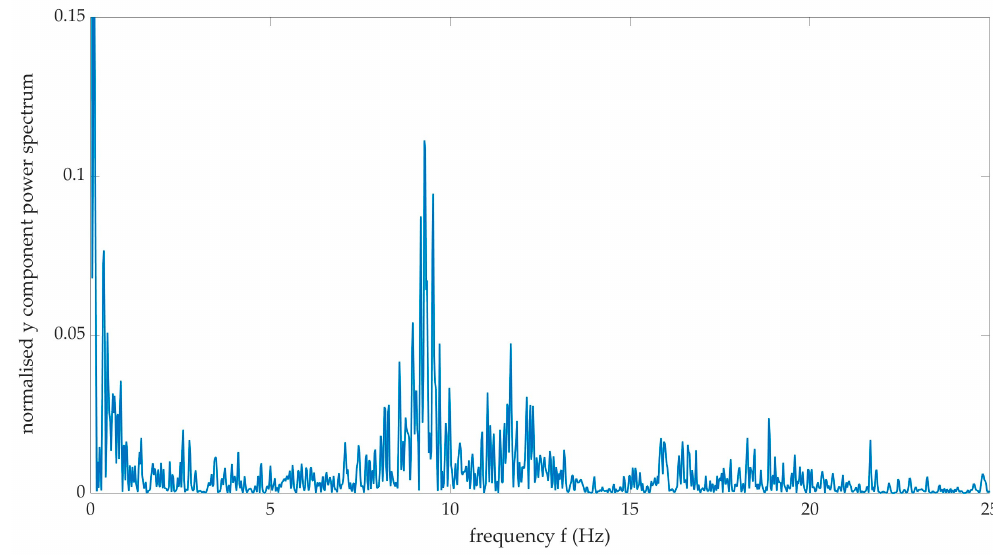
Figure 11. Spectra of GoPro tailplane time series data.